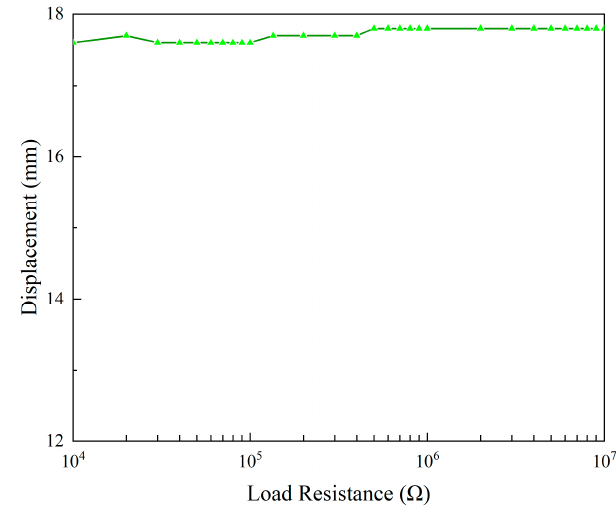
Figure 16. Displacement versus the load resistance.